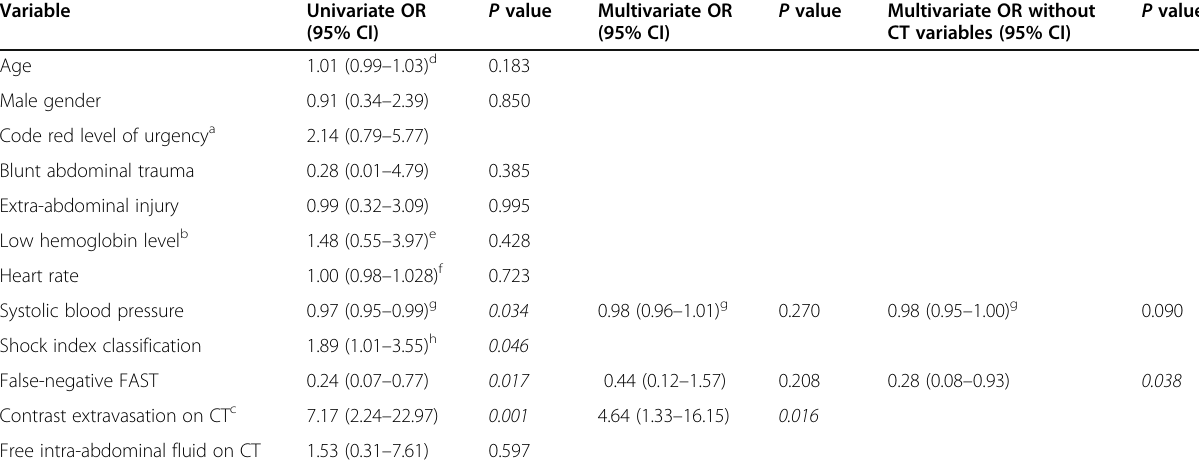
Table 4 Association of variables with an unfavorable outcome in univariate analysis, multivariate analysis, and multivariate analysis without CT